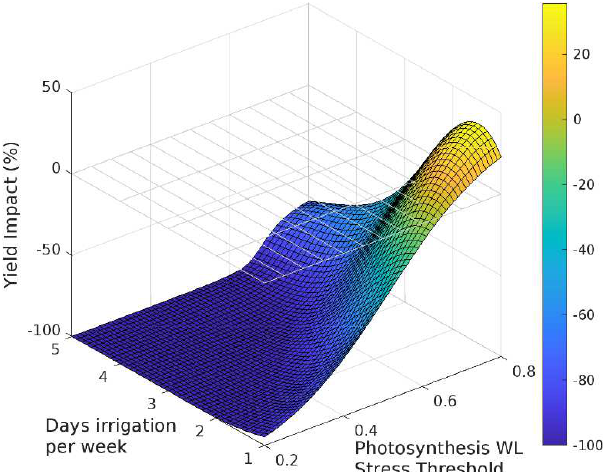
Figure 3. Sensitivity of the response function associated with photosynthesis on grain yield.